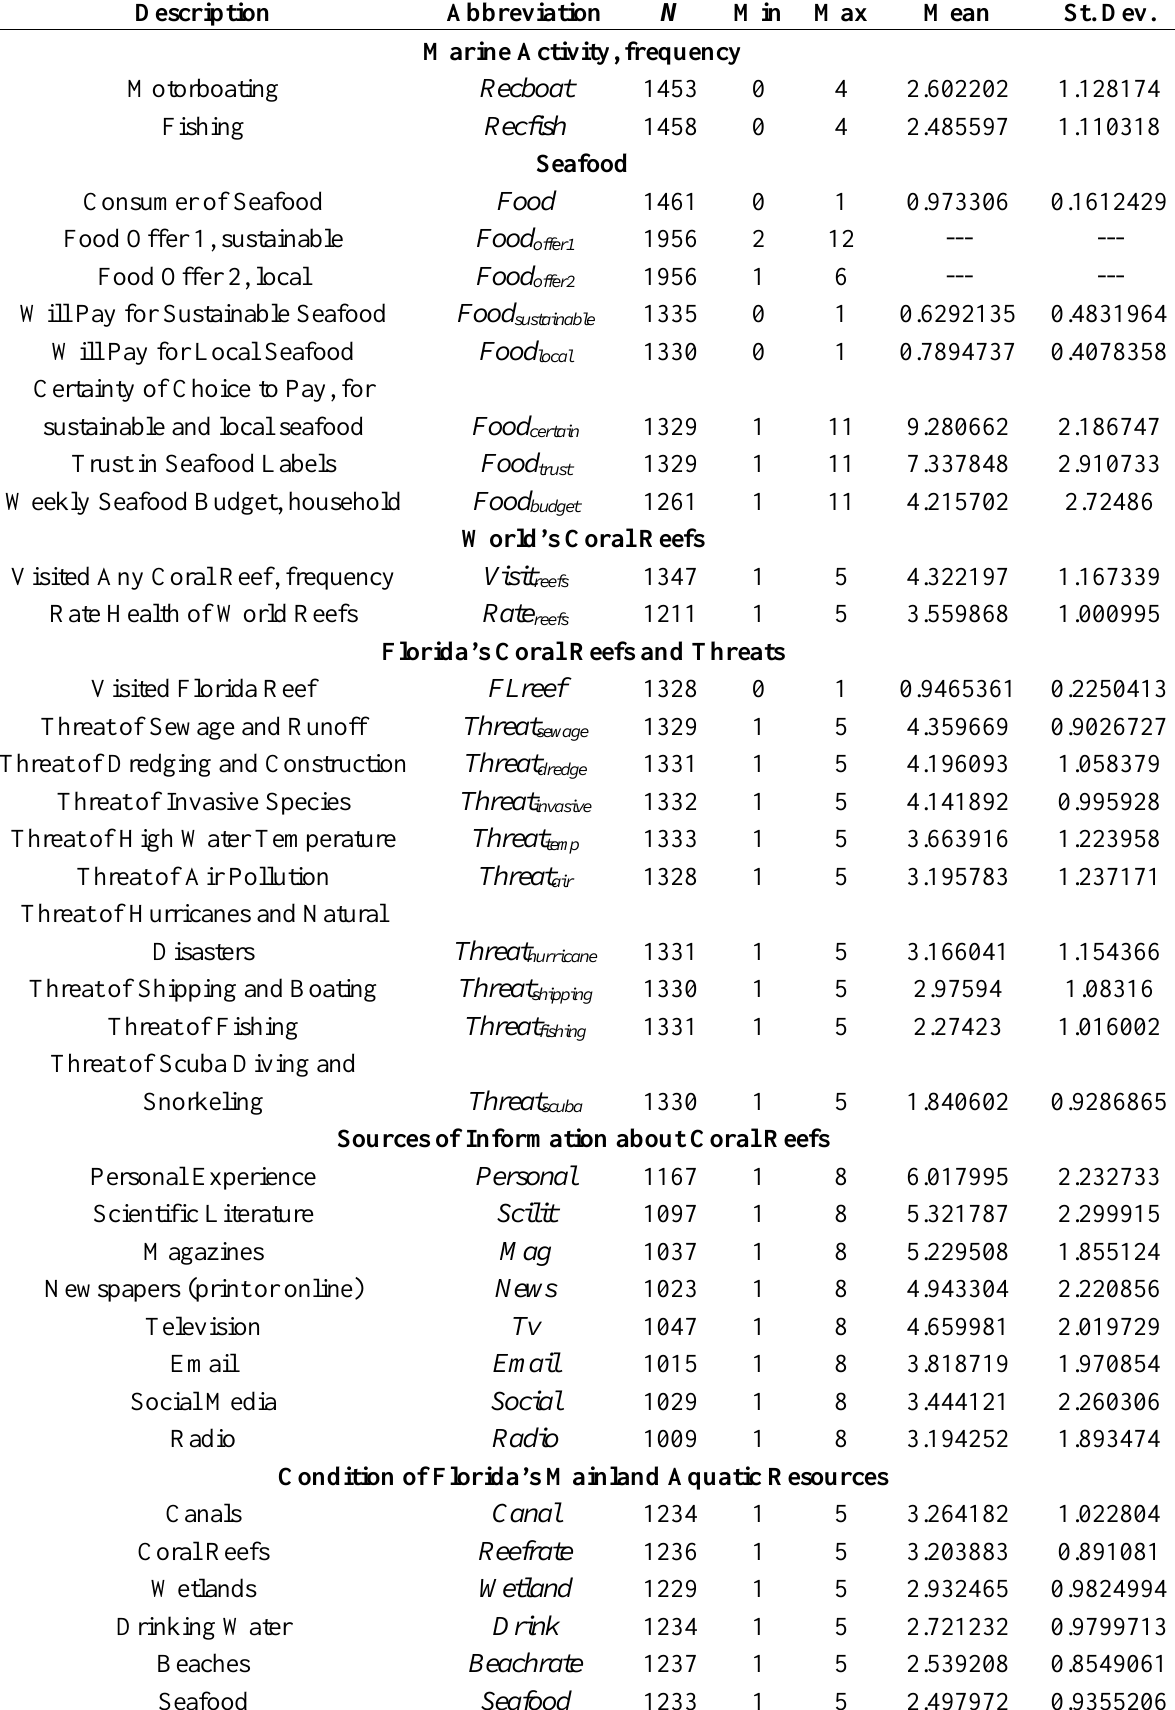
Table 2. Variable definitions and descriptive